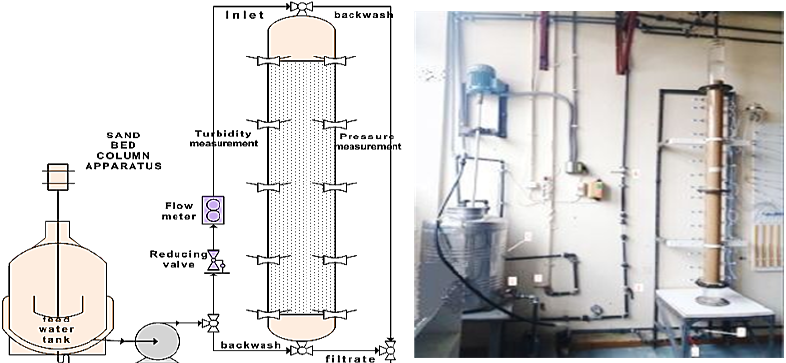
Figure 2. Deep-Bed Filtration